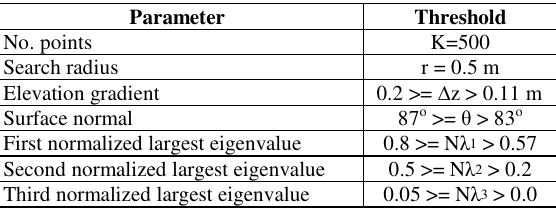
Table 2. Thresholds of different parameters-fifth phase.